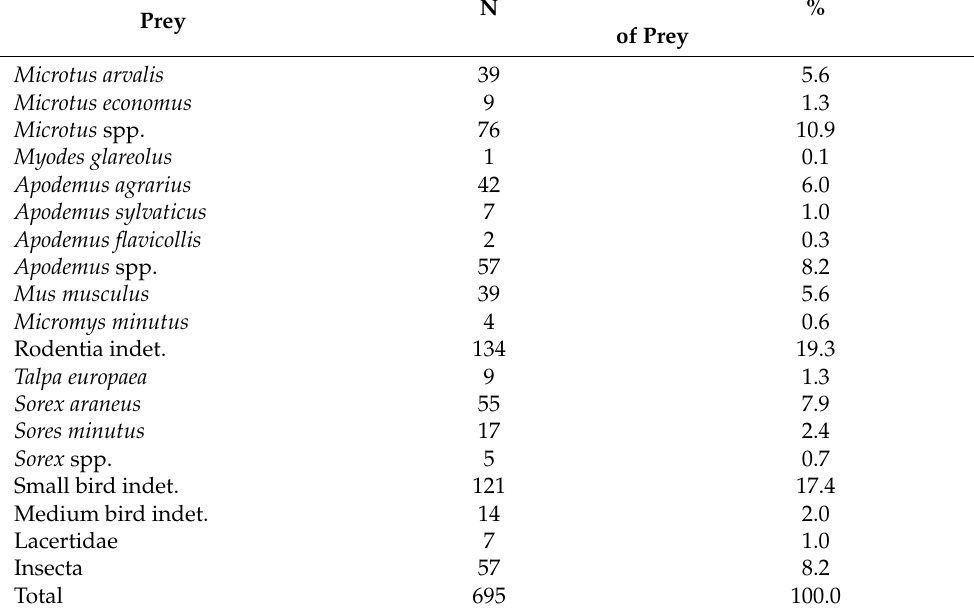
Table A2. The diet composition of kestrel ( Falco tinnunculus ) in the breeding seasons 2011–2018 in the area of study (central Poland, vicinity of Rog ó w village, Experimental Forest Station of Warsaw University of Life Sciences), based on pellet analysis and prey remains collection. N – number of prey items.